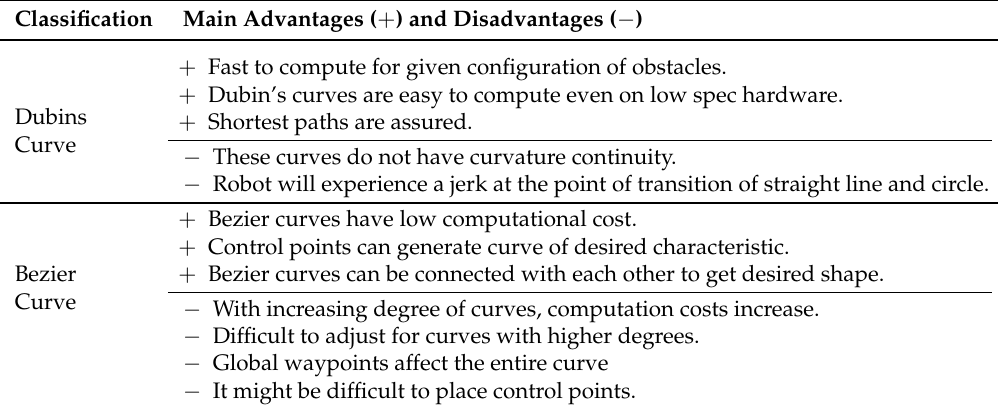
Table 1. A comparison of various trajectory smoothing